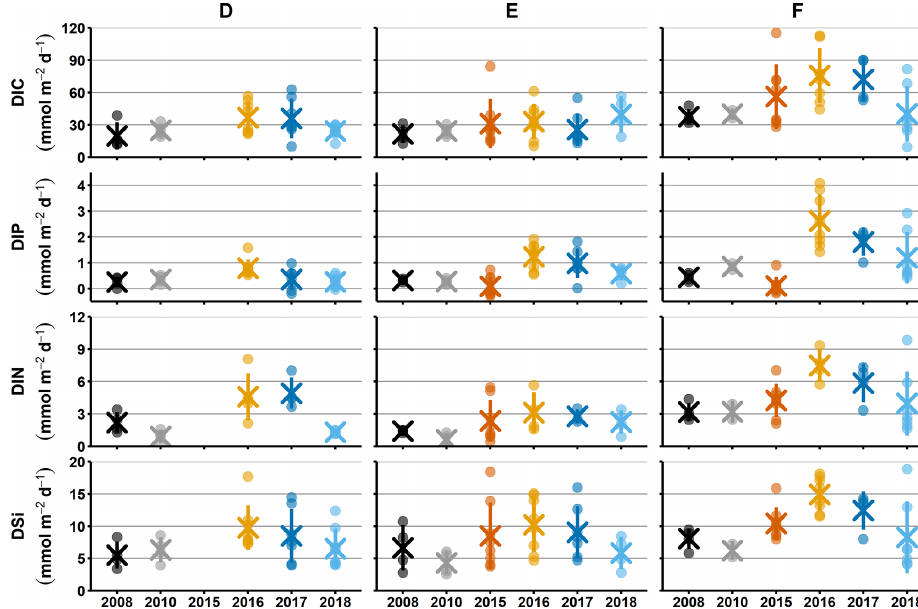
Figure A2. Sediment–water fluxes measured with the benthic chamber lander. Flux data are from before the inflow (2008, 2010; Hall et al., 2017; Nilsson et al., 2019; Viktorsson et al., 2013), right after the inflow (2015; Hall et al., 2017), and post-inflow (2016–2018; this study). There are no data from station D in